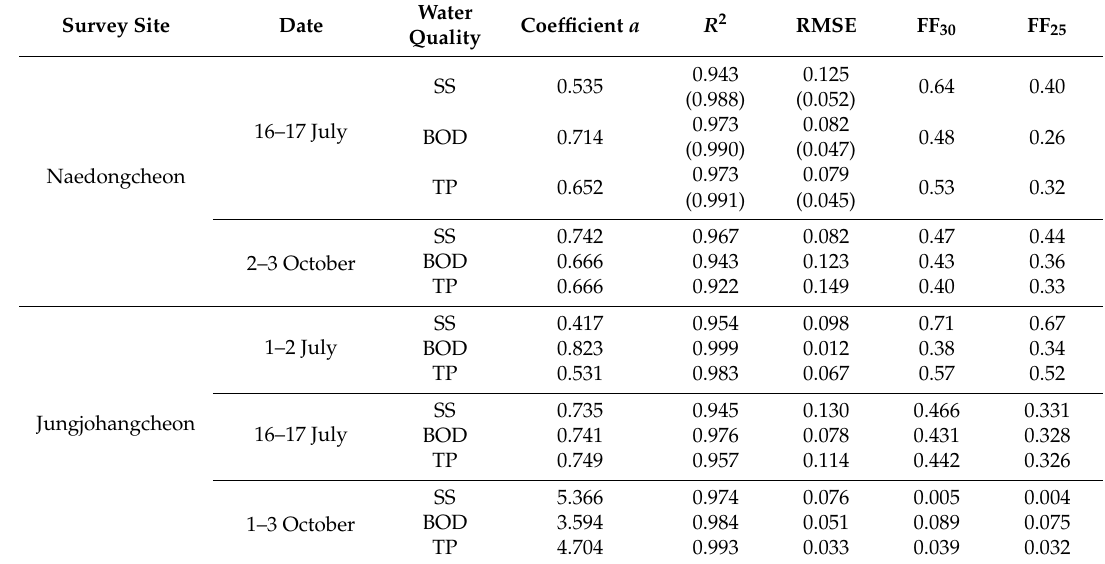
Table 5. Nonlinear regression analysis between the cumulative runoff mass and volume data using the power function and FF 30 and FF 25 values for selected rainfall